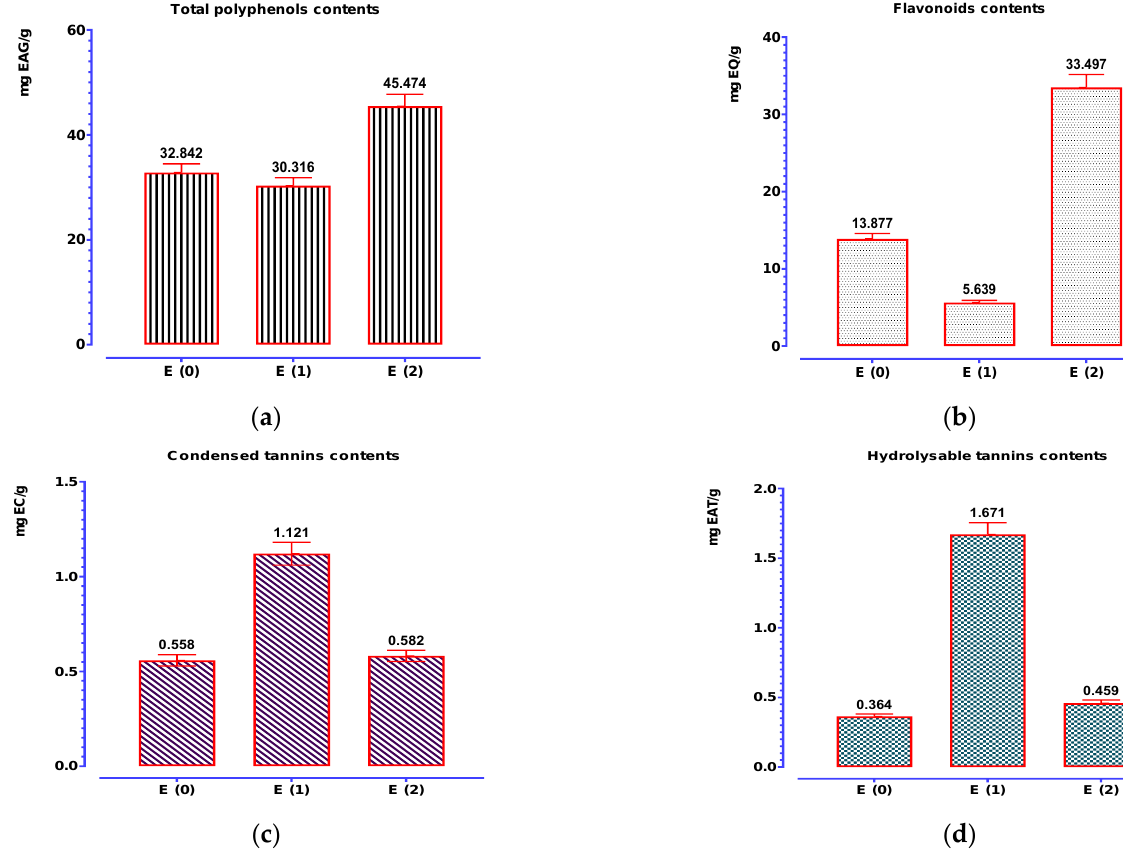
Figure 4. Contents of phenolic compounds: ( a ) total polyphenols; ( b ) flavonoids; ( c ) condensed tannins; ( d ) hydrolyzable tannins. Mean values ± standard deviations of determinations performed in triplicate are reported. Means are significantly different ( p < 0.001).